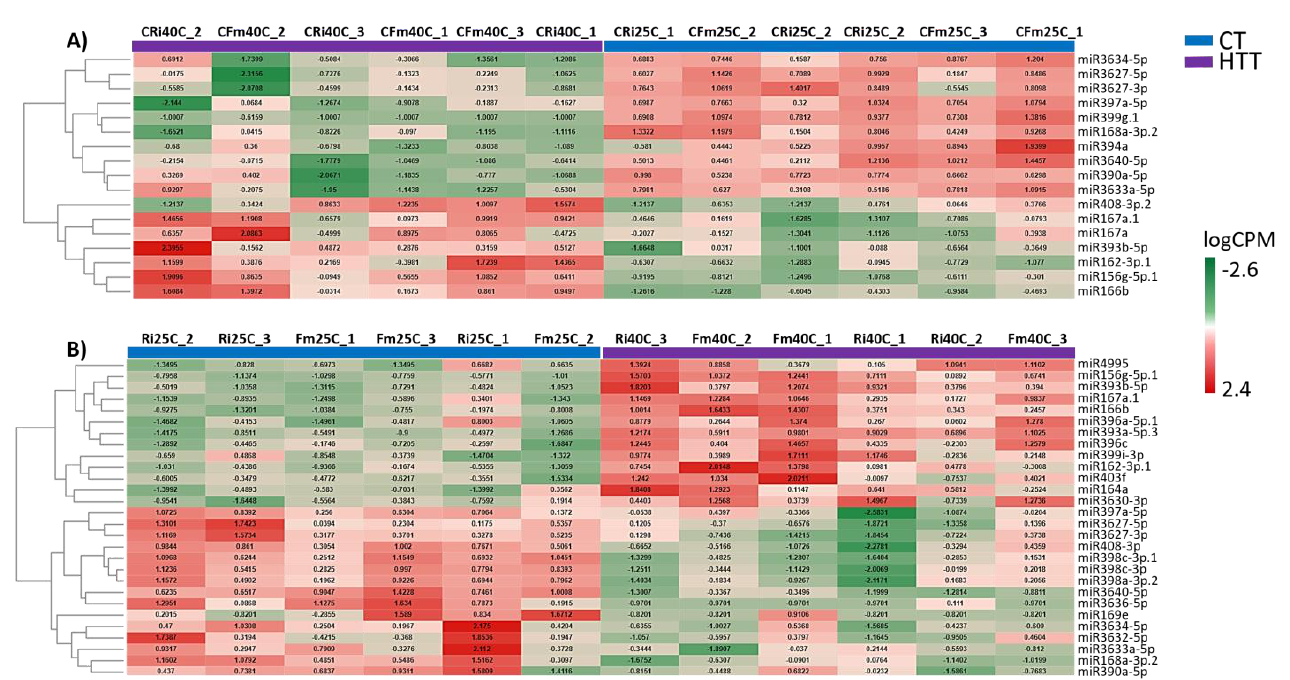
Figure 1. Heatmap showing differentially expressed miRNAs in ( A ) non – mycorrhizal and ( B ) my- corrhizal grapevines, maintained at control temperature (CT — 25 °C) or subjected to a high – temper- ature treatment (HTT — 40 °C).